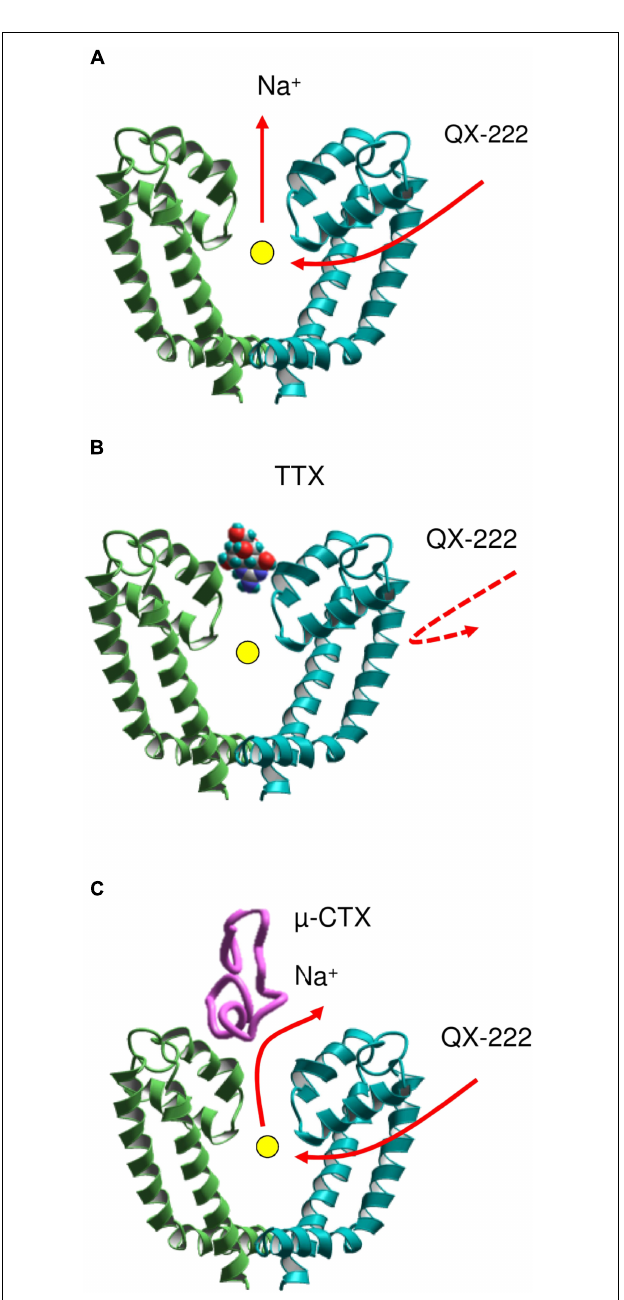
FIGURE 3 | A scheme of coupled movement of a sodium ion and ligand QX-222 in the closed cardiac sodium channel (Bruhova et al., 2008). (A) The permanently charged QX-222 reaches the inner pore via III/IV repeat interface and displaces the resident ion that leaves the central cavity through the selectivity filter. (B) When the outer pore is blocked by TTX, the sodium ion is trapped in the central cavity and prevents binding of QX-222. (C) A µ -CTX mutant does not completely block the sodium current. The sodium ion can escape through the incompletely sealed outer pore and vacate the cation-attractive central cavity for binding of